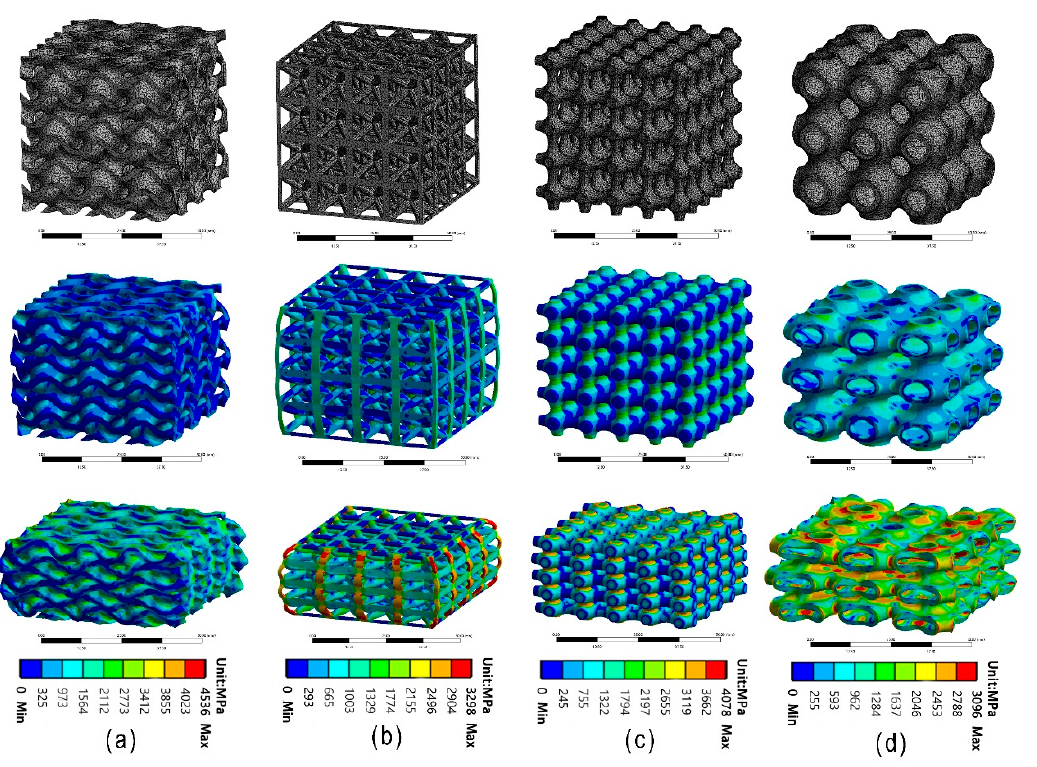
Figure 6. ( a ) Gyroid surface, ( b ) Bcc lattice structure, ( c ) Primitive surface, ( d ) truss lattice structure, meshing and stress cloud of finite element analysis under given strain.